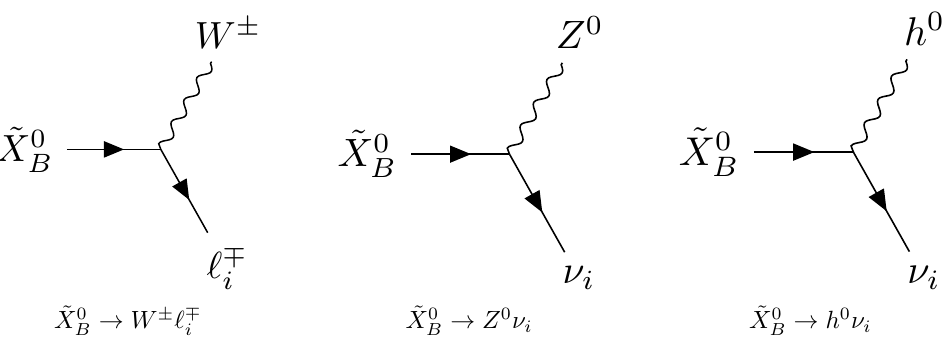
Figure 4. RPV decays of a general massive Bino neutralino ~ X 0 each with i = 1 ; 2 ; 3, that allow for Bino neutralino LSP decays. The decay rates into each individual channel were calculated analytically in our previous paper and are reproduced in appendix